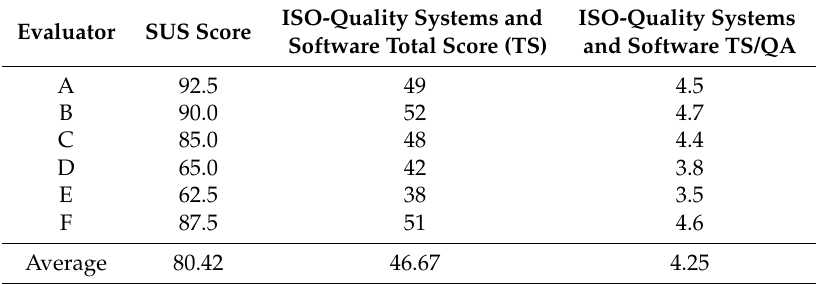
Table 4. First prototype scores from the first and second parts of the